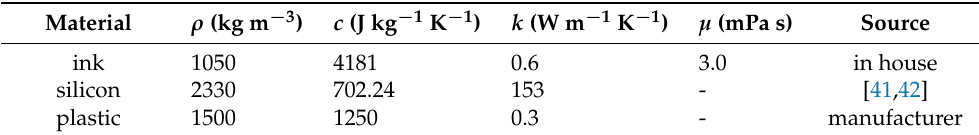
Table 2. Material properties for printhead model. Note that all properties are assumed to be invariant with temperature.